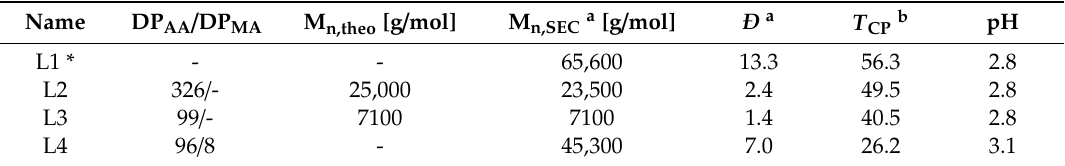
Table 1. Characterization of linear poly(acrylic acid) (PAA) and poly(acrylic acid- co -methyl acrylate) (P(AA- co -MA)) polymers.